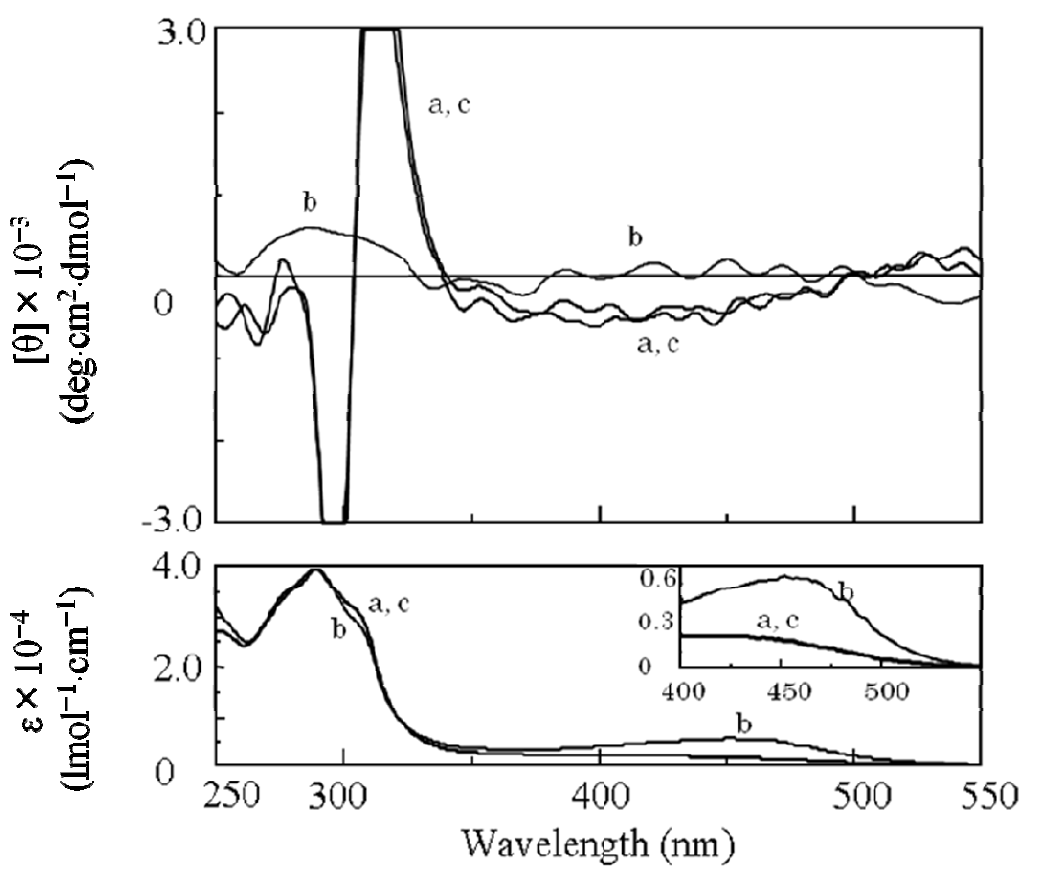
Figure 4. CD and UV-Vis spectra of poly( 1 ) in (a) THF, (b) THF/DMSO = 80/20 (v/v) and (c) THF/DMSO = 99/1 (v/v) ((c) was the solution prepared by addition of THF to the solution of